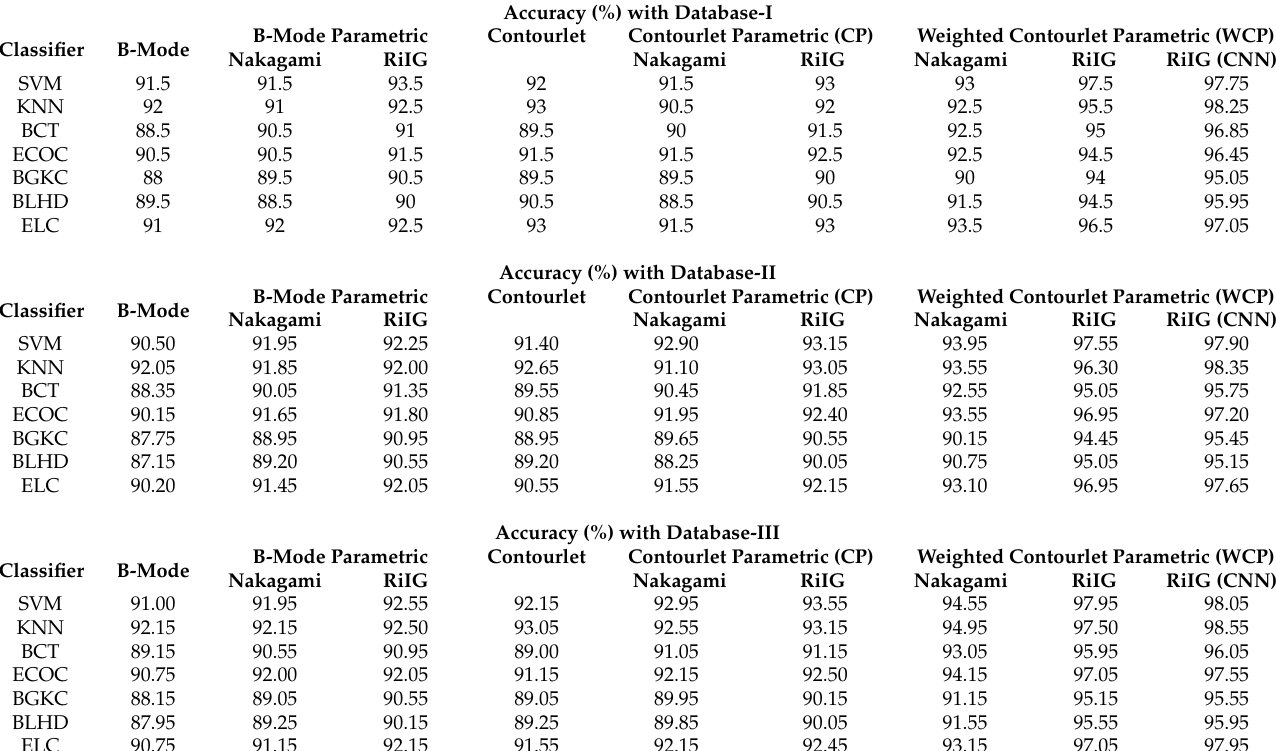
Table 6. The classification performances for different types of images with databases I, II, and